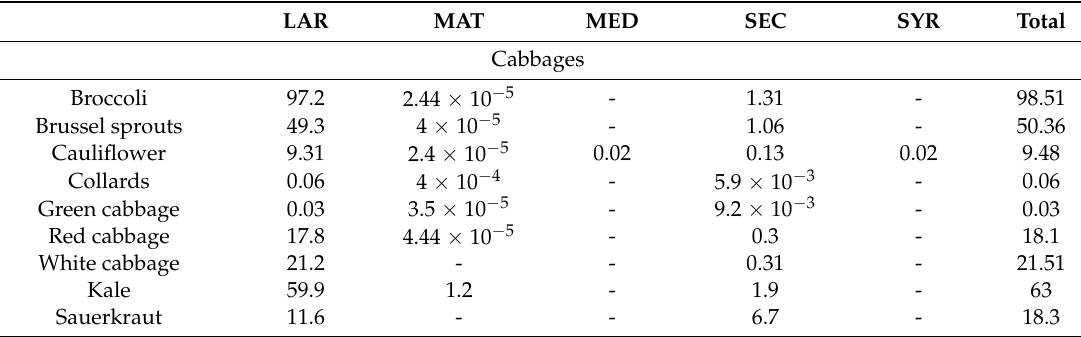
Table 4. Lignan contents of vegetables (mg/100g food)